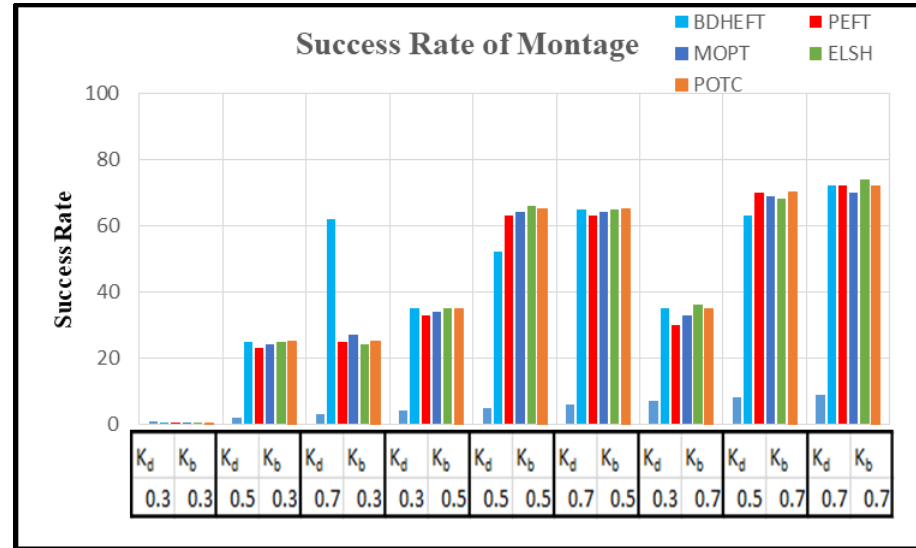
Figure 8. Success rate of the epigenomics workflow.